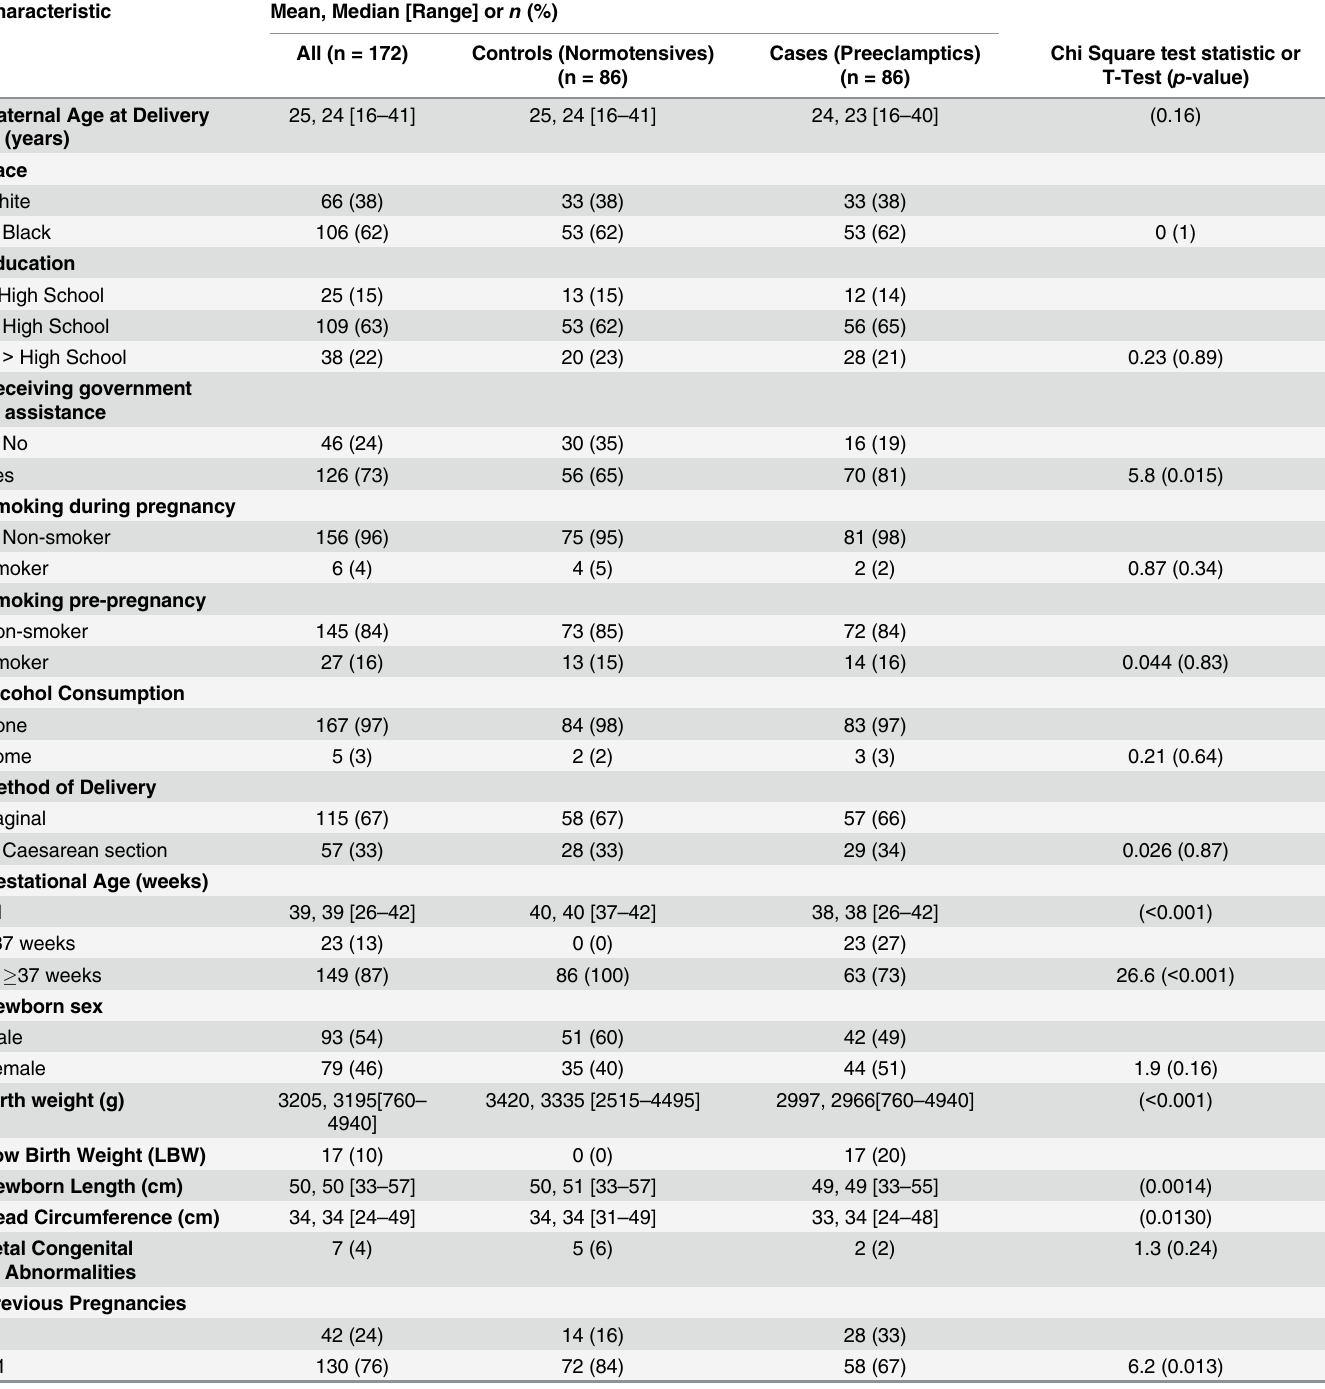
Table 1. Demographic Characteristics of the Nested Case-Control Study